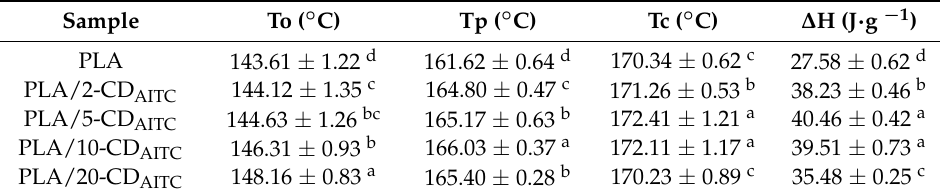
Table 3. Thermal properties of the PLA films with differen t amounts of β -CD/AITC.